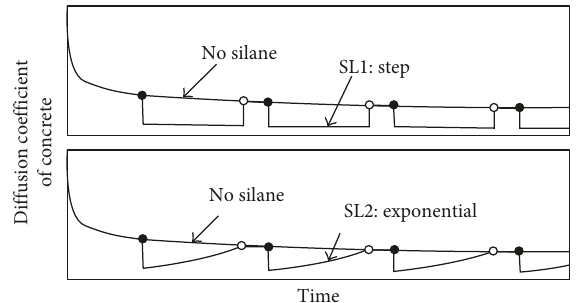
Figure 4: Diffusion coefficient of original and silane-treated concrete: (a) SL1 and (b) SL2.